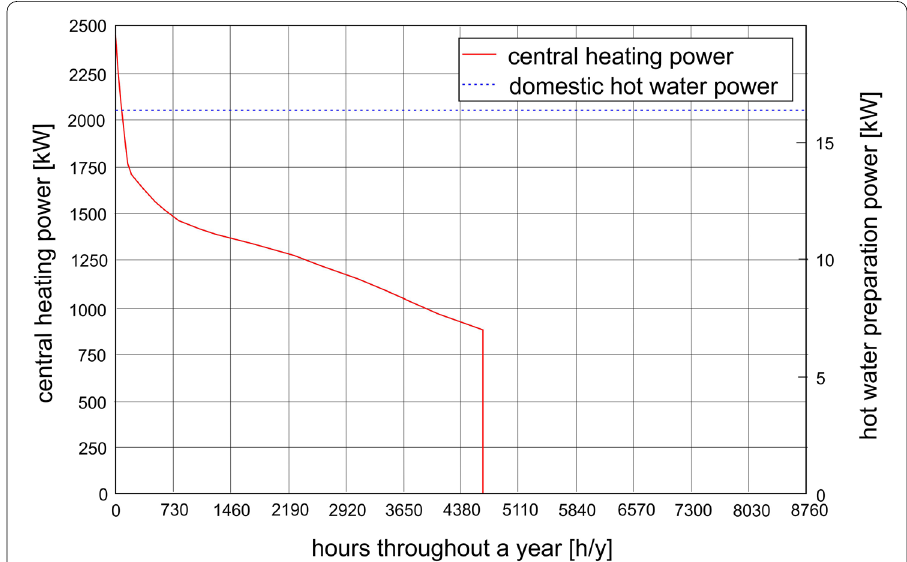
Fig. 9 Structured demand curve for heating power and domestic hot water preparation for the large greenhouse